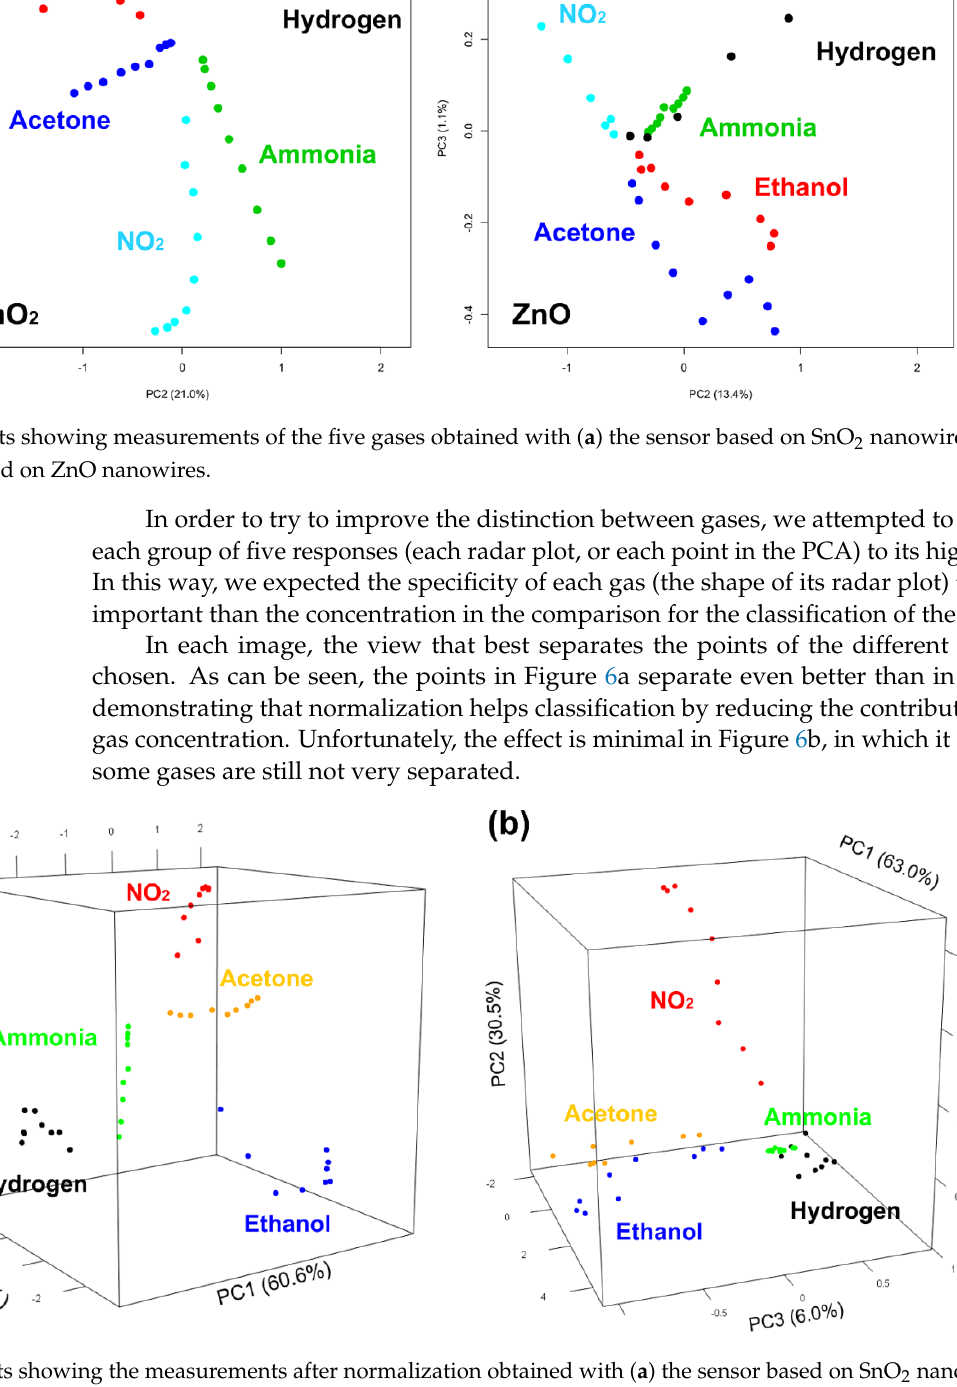
Figure 6. PCA plots showing the measurements after normalization obtained with ( a ) the sensor based on SnO 2 nanowires and ( b ) the sensor based on ZnO nanowires.